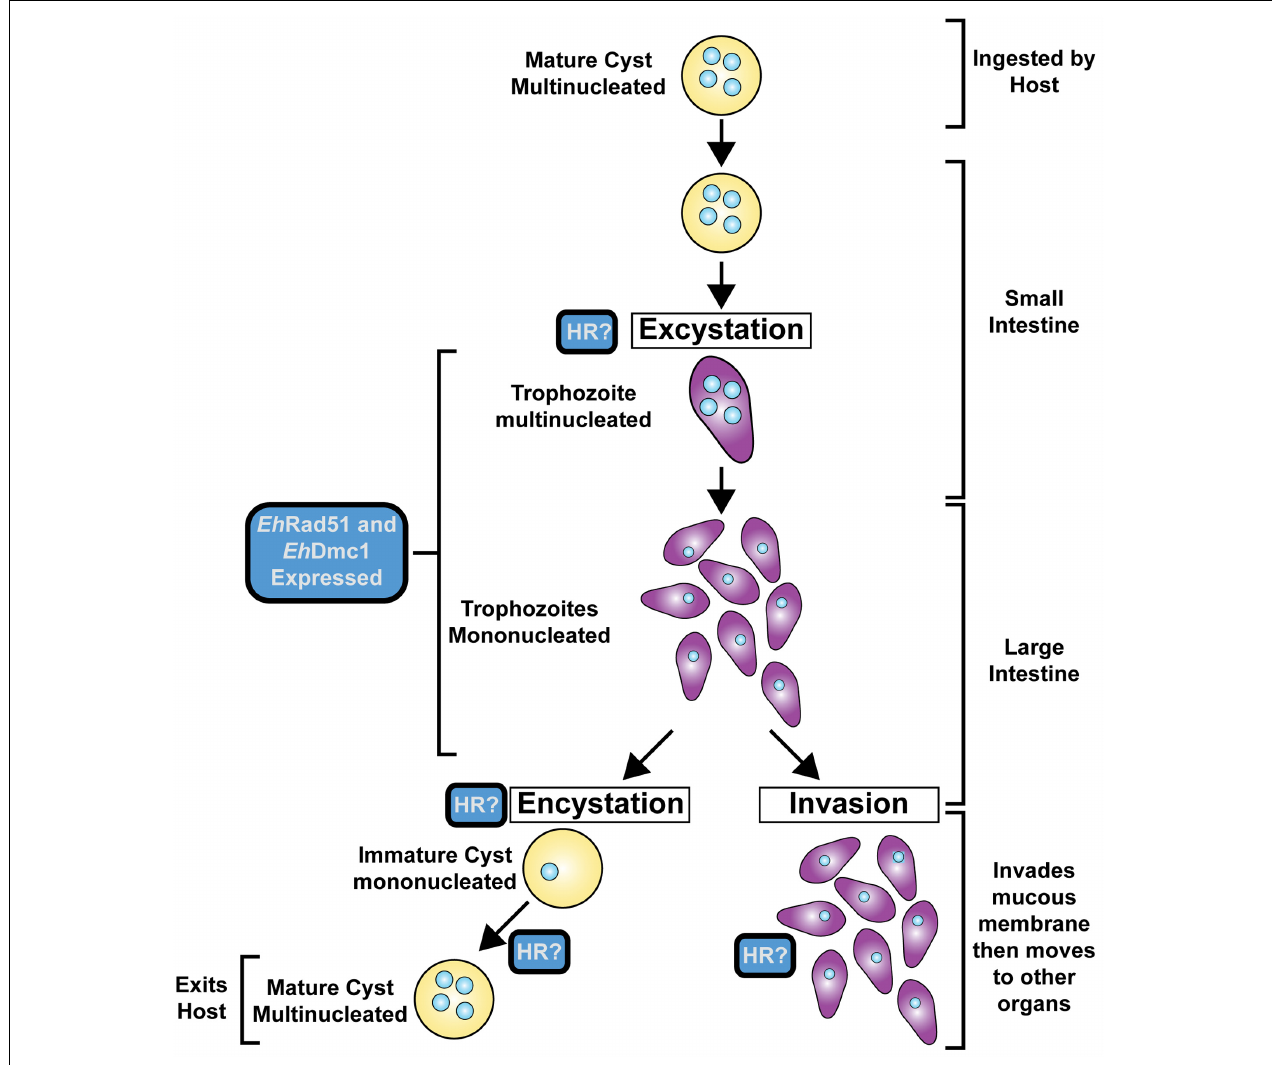
FIGURE 3 | Life Cycle of Entamoeba histolytica . The human host ingests the mature cyst. The cyst moves to the small intestine where excystation occurs, resulting in the release of multiple trophozoites that migrate to the large intestine. Trophozoites either invade the mucous membrane of the host or encyst and exit the host for future